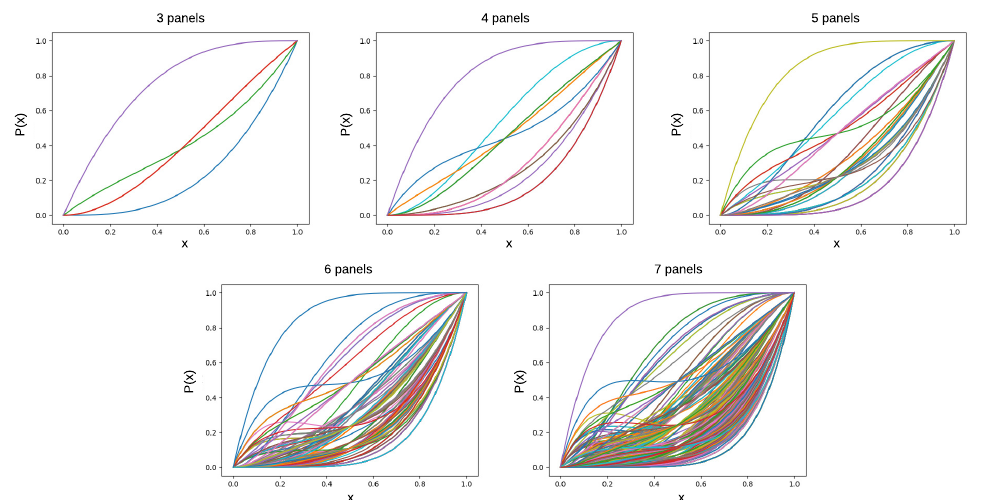
Figure 12. Associated polynomials for every array-digraph ranging from 3 to 7 panels. It is noticed that in the Non- isomorphic column of Table 1, for 3 panels there are 5 different graphs, but only 4 lines can be seen for the 3 panels plot. This is because some non-isomorphic graphs can be associated with the same reliability polynomial and thus, they overlap. In every plot, the polynomial with the greatest/smallest values for every x ∈ ( 0,1 ) correspond to the all-parallel/all-series graph.